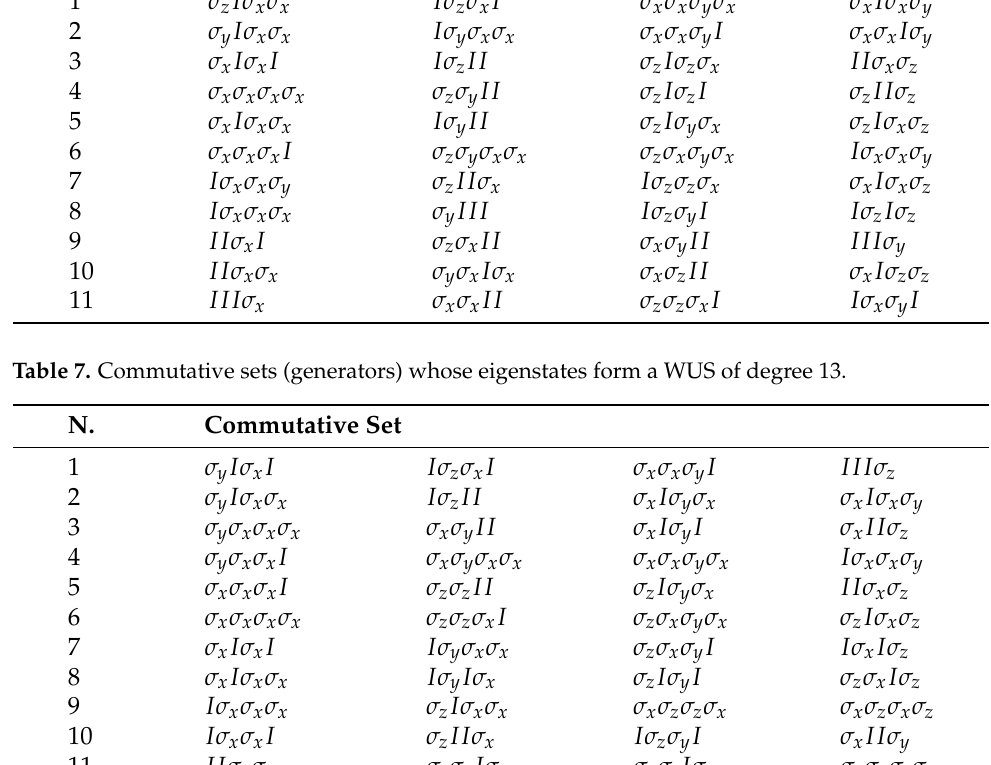
Table 6. Commutative sets (generators) whose eigenstates form a WUS of degree 11. N.